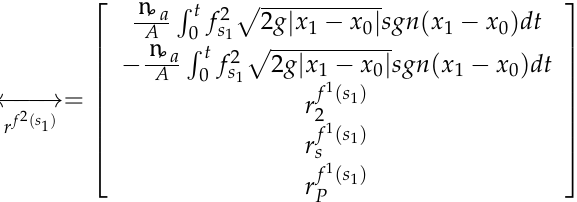
Figure 1. Three-pond hydraulic system.